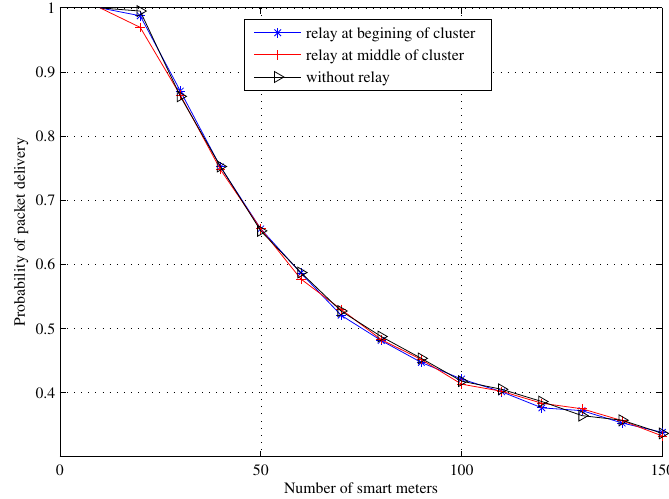
Figure 11. Effect of data collector (DC) position on PPD (with NPLC last